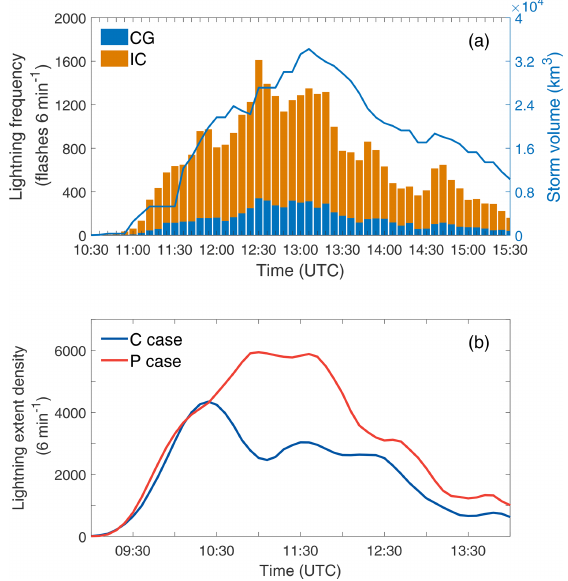
Figure 8. Temporal variation in (a) observed total lightning fre- quency and (b) simulated flash extent density (FED). In (a) , orange represents IC lightning and blue represents CG lightning. The solid line represents the storm volume associated with radar reflectivity exceeding 30dBZ. In (b) , the red line represents the P case and the blue line represents the C